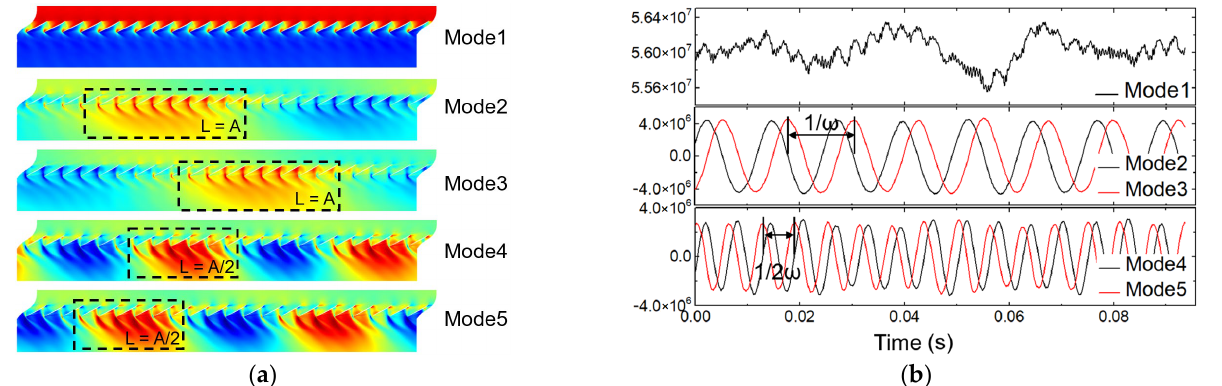
Figure 13. POD modes of stable-stall stage. ( a ) POD modes. ( b ) Mode coefficient.